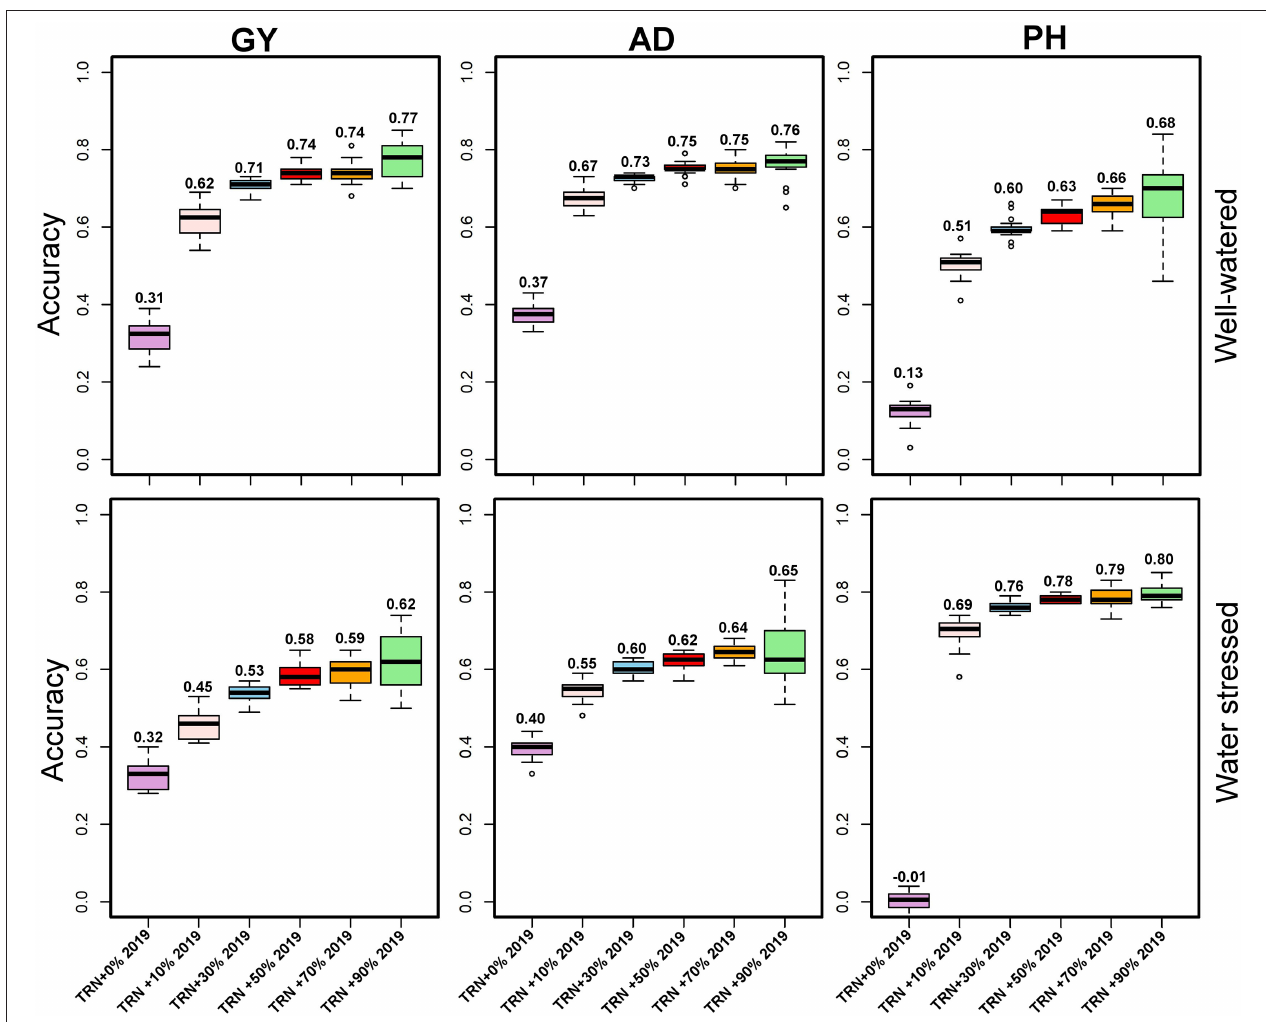
FIGURE 5 | Prediction accuracies for grain yield and agronomic traits assessed estimated from independent validation schemes using a training population (TRN) consisting of 2017- and 2018-years breeding data and 10, 30, 50, 70, and 90% of 2019 data converted from the testing population (TST) to the training population under optimum and managed drought conditions. GY, grain yield; AD, anthesis date; PH, plant